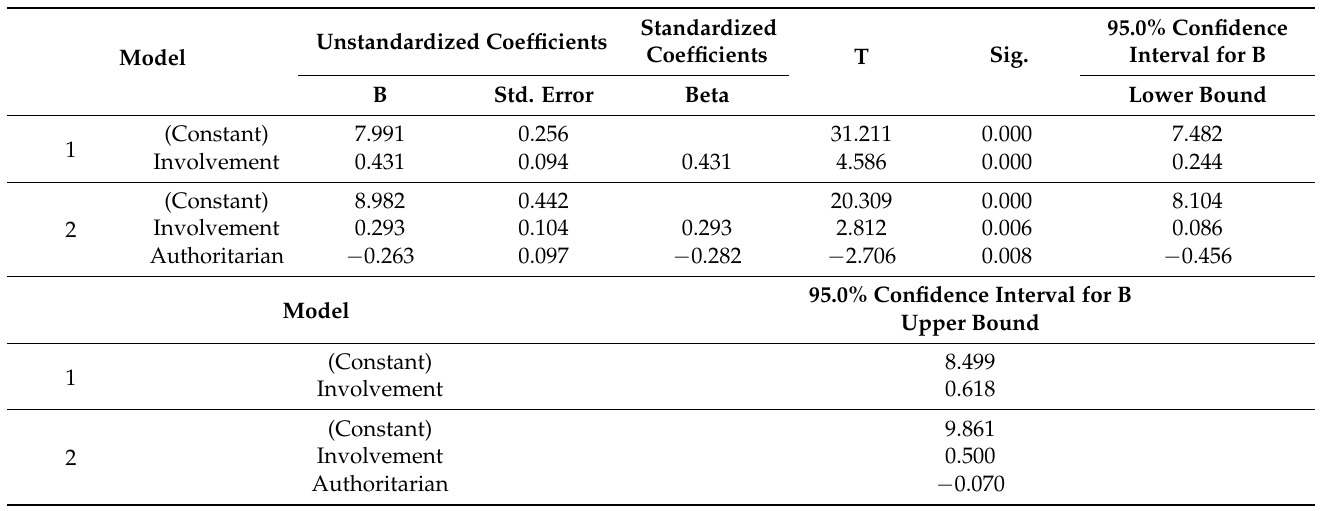
Table 3. Correlation between involvement and authoritarian style and school